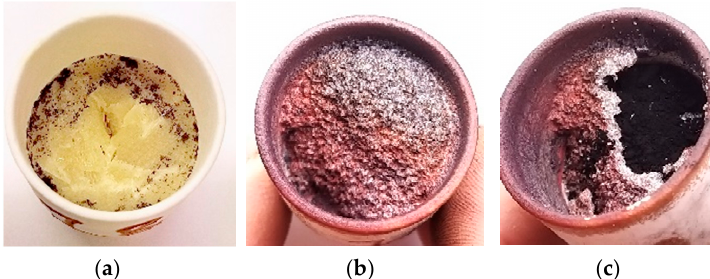
Figure 4. Images of the crucibles: ( a ) and ( b ) two typical scenarios of the CKN slag appearing after thermal treatment; ( c ) opened CKN slag cover.